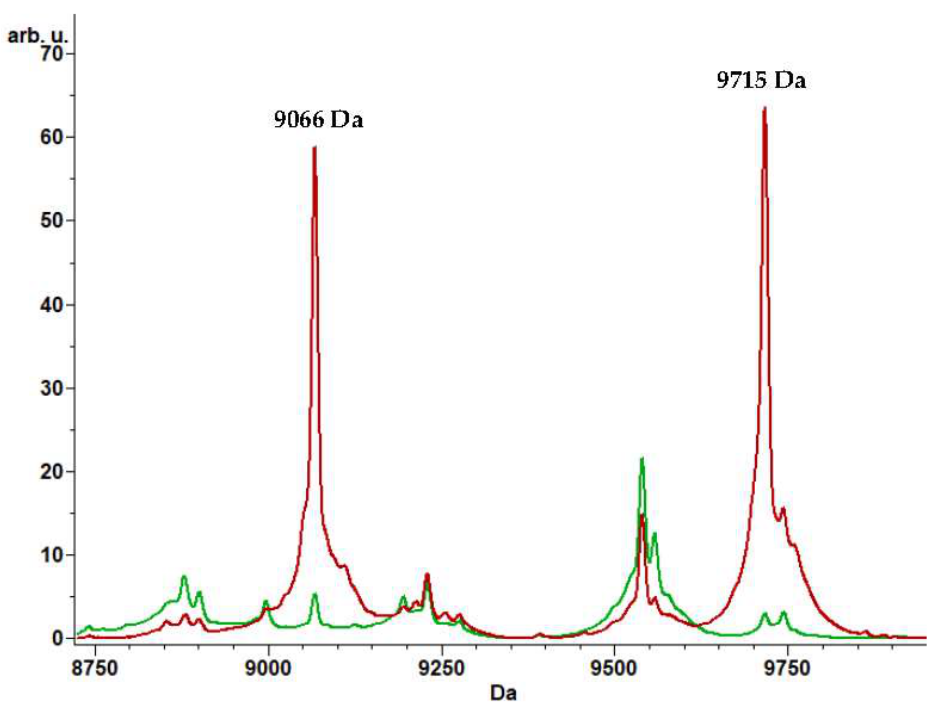
Figure 3. Peaks used for the classification by the SNN-based CAM (9066 Da and 9715 Da) not involved by the GA and QC algorithms (colR-Ec “training set” Average spectrum in red and colS-Ec “training set” Average spectrum in green). arb. u. arbitrary units; Da dalton.